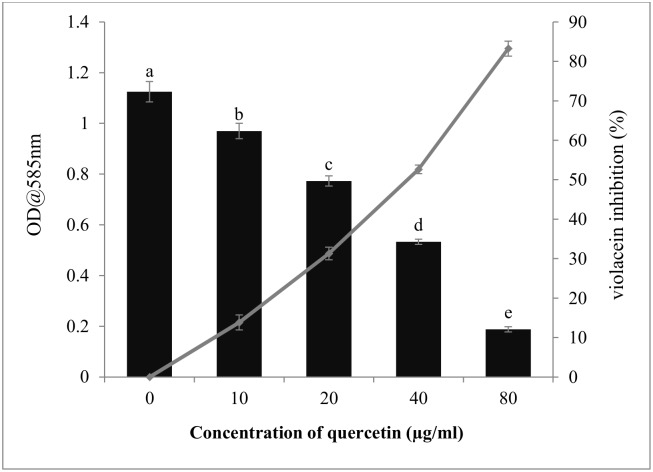
Inhibition of violacein production in C.violaceum (CECT5999)by quercetin at different concentration (0–80μg/ml).Line graph represents the percentage inhibition. Vertical bars represent the mean values of triplicates with standard deviation. Same letters in the column are not significantly different (p< 0.05).